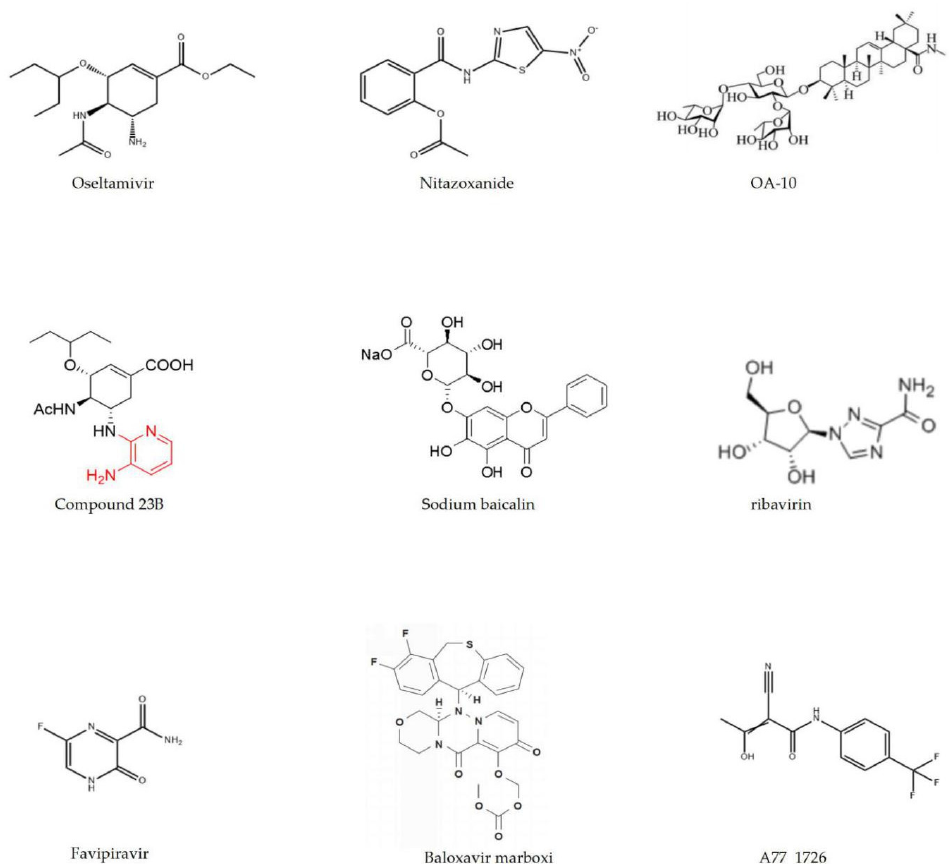
Figure 2. The molecular structures of chemical synthesis drugs.